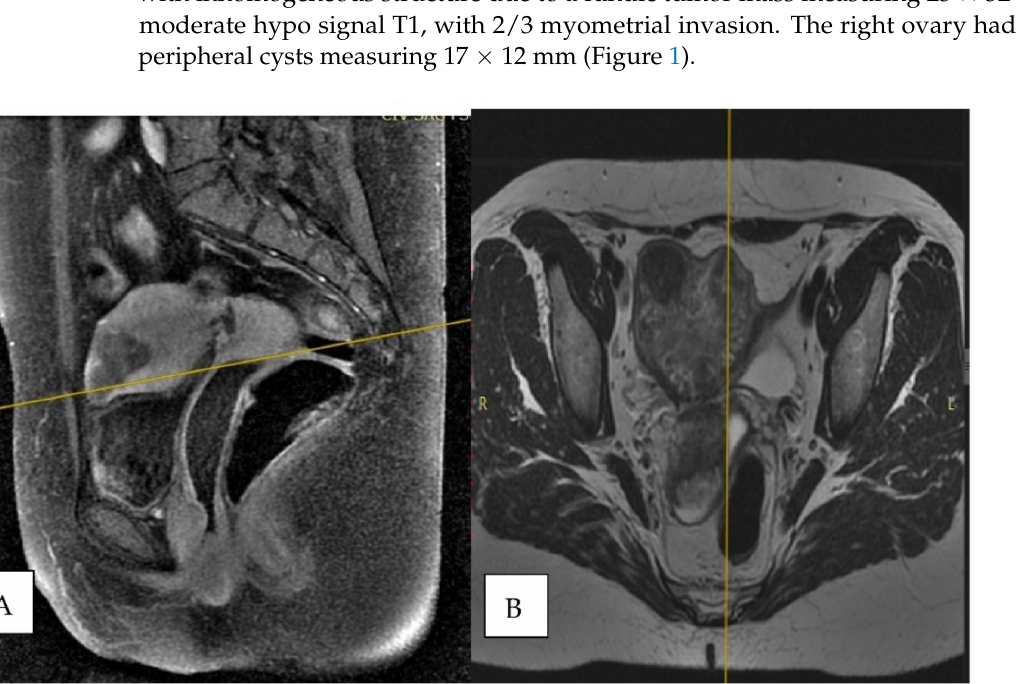
Figure 1. Radiological images of abdominal MRI scan with gadolinium ( A ) sagittal: perpendicular al coronal (FSE T1-FS), ( B ) axial oblique T2-weighted sequence showing large uterus with multiple heterogeneous masses centered within the uterine